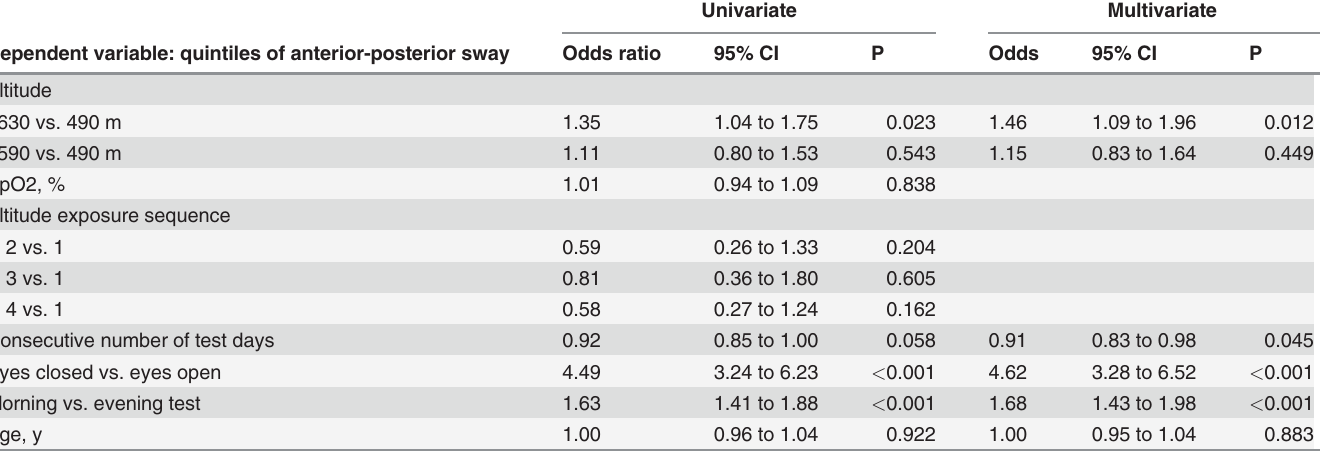
Table 5. Effect of altitude on anterior-posterior sway: ordinal logistic regression analysis.